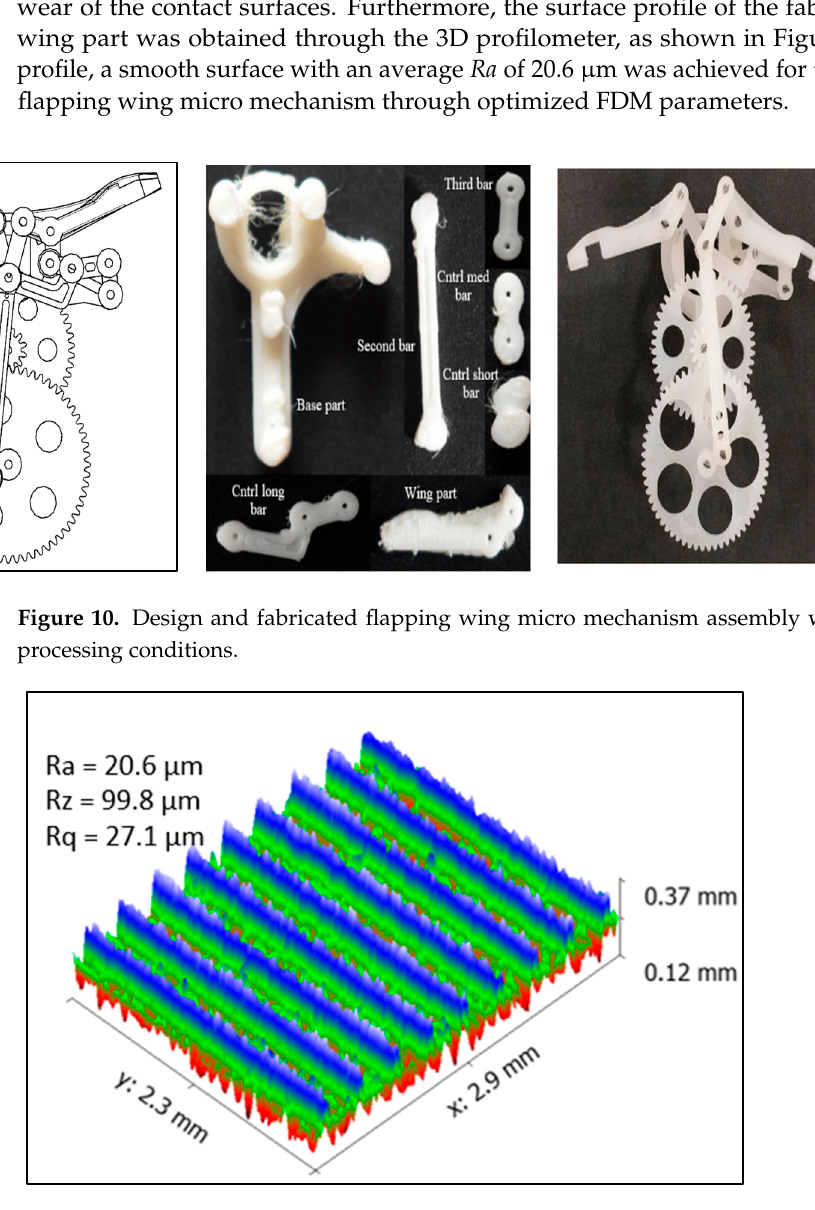
Figure 11. Three-dimensional surface profile of flapping wing mechanism part fabricated with op- timal FDM parameter settings.